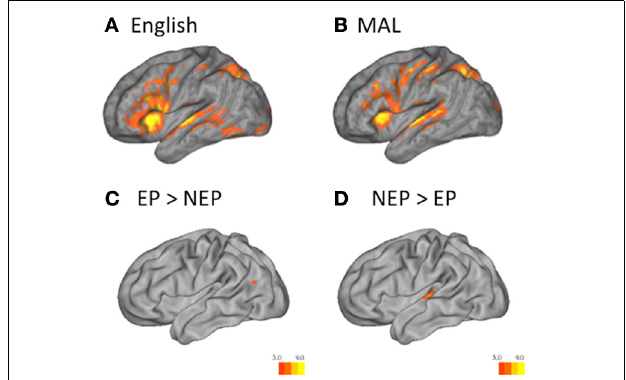
FIGURE 3 | Univariate Analysis. One sample t -tests reveal that English (vs. implicit baseline) across groups (A) and MAL (vs. implicit baseline) across groups (B) are associated with the recruitment of classic language regions. Two sample t -tests reveal that EP learners recruit the left temporo-parietal region more than NEP learners (EP > NEP) (C) , while NEP learners recruit the superior-temporal gyrus more than EP learners (NEP > EP) (D) Heat maps indicate the t